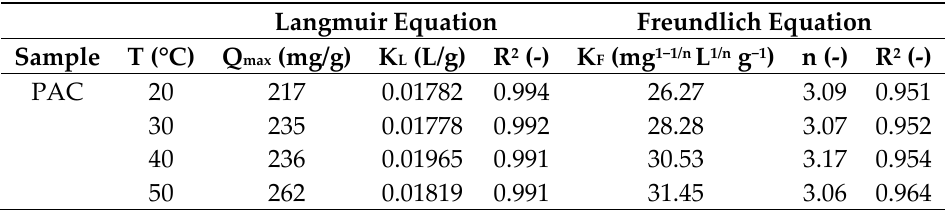
Table 1. Equilibrium parameters for the adsorption of Pb(II) onto